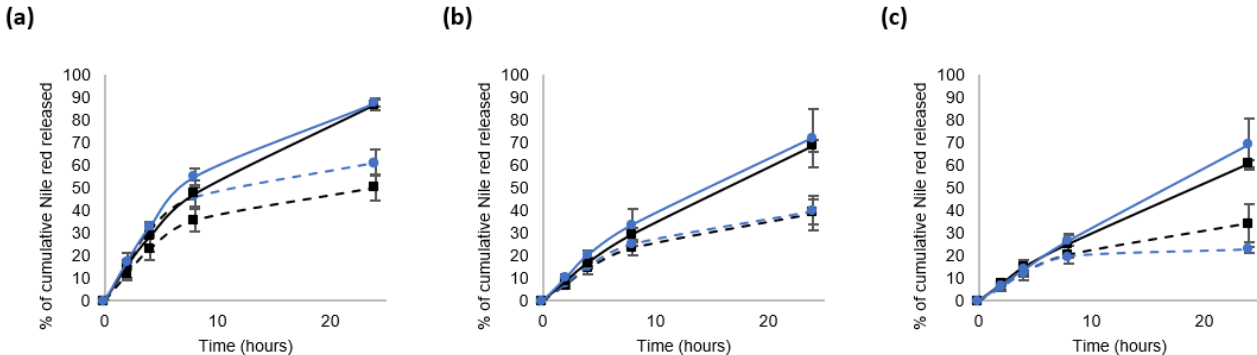
Figure 6. In vitro release of Nile red from the nanocarriers at 37 °C in water. The blends were used at three concentrations: 4 mg/mL ( a ), 10 mg/mL ( b ) or 16 mg/mL ( c ). The curves are encoded as follows: blend 1 (black square) or blend 2 (blue round); without GSH (dashed lines) and in the presence of 10 mM GSH (continuous lines).